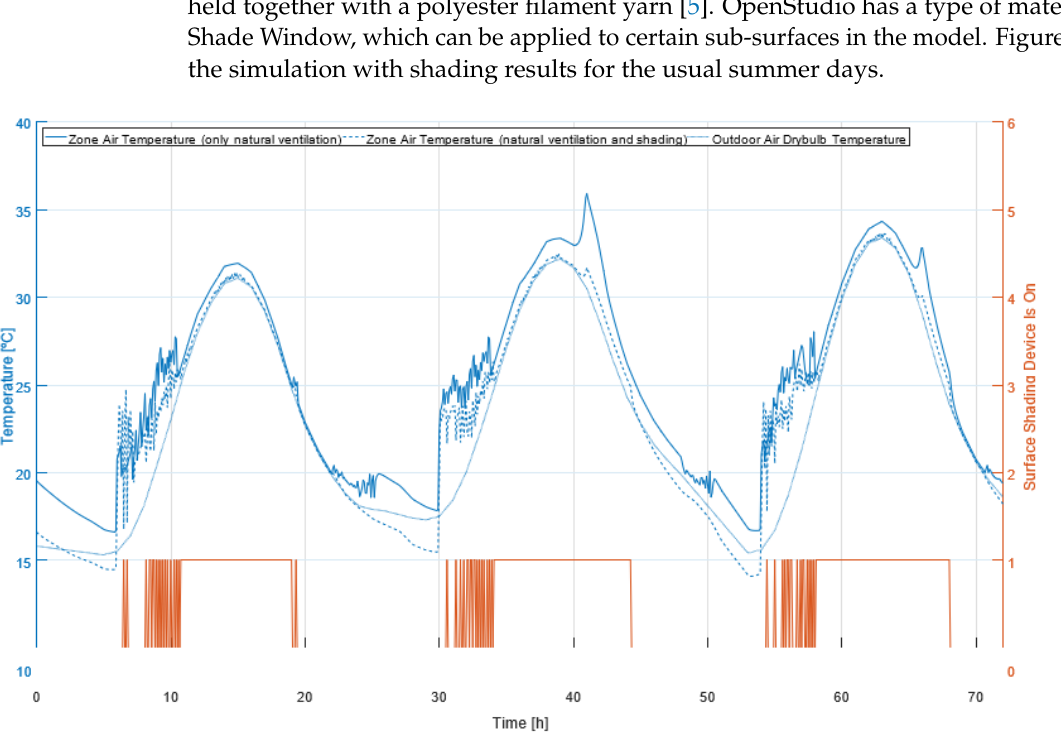
Figure 12. Only naturally ventilated, naturally ventilated with shading and outside temperature of the greenhouse between the 13 and 15 of August.